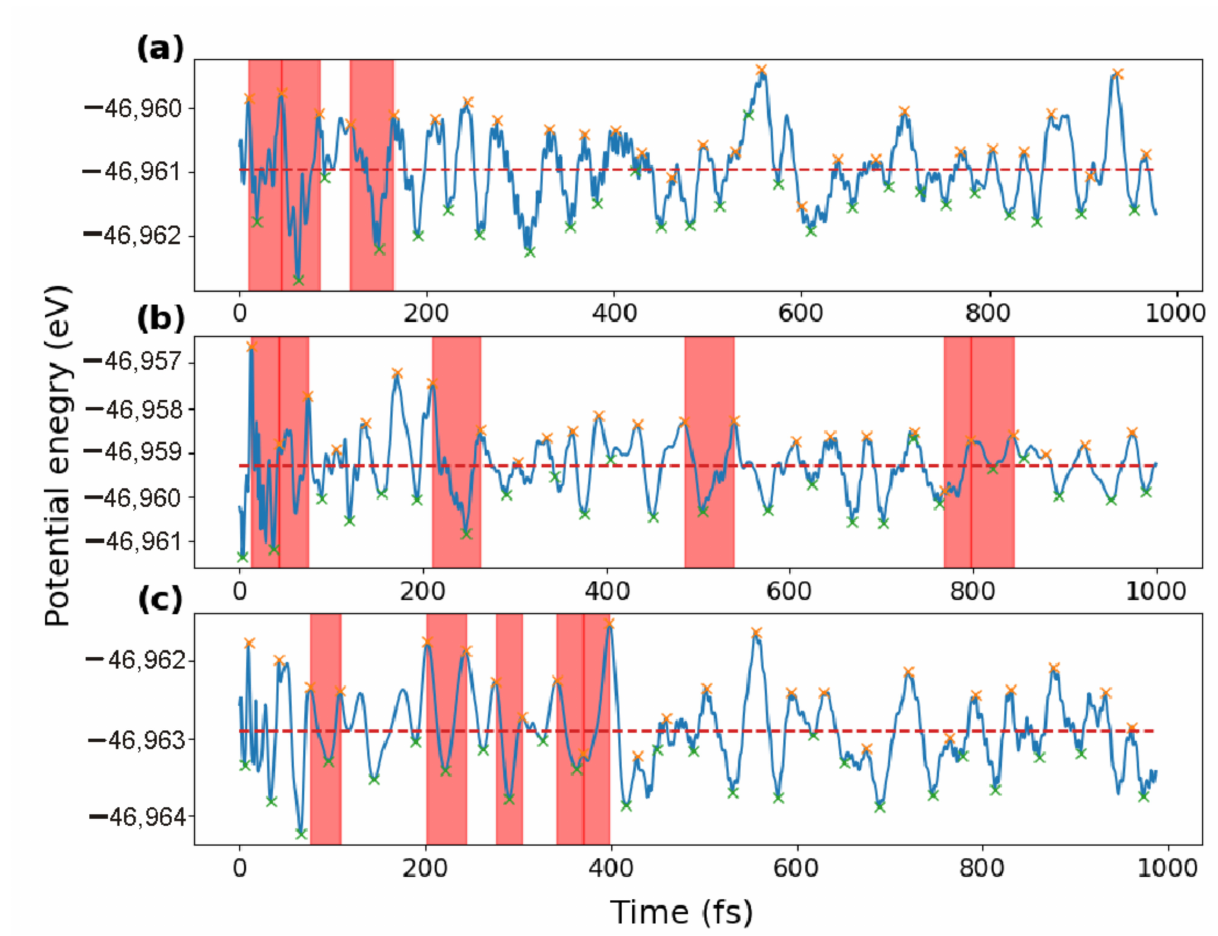
Figure 6. Change in the potential energy of the perovskite system over time in calculations ( a ) 1, ( b ) 2, and ( c ) 3; red stripes show the proton jumps among oxygen atoms; the average potential energy is shown by the dashed line; the initial placement of a proton corresponds to its average initial coordinates for each selected series of five